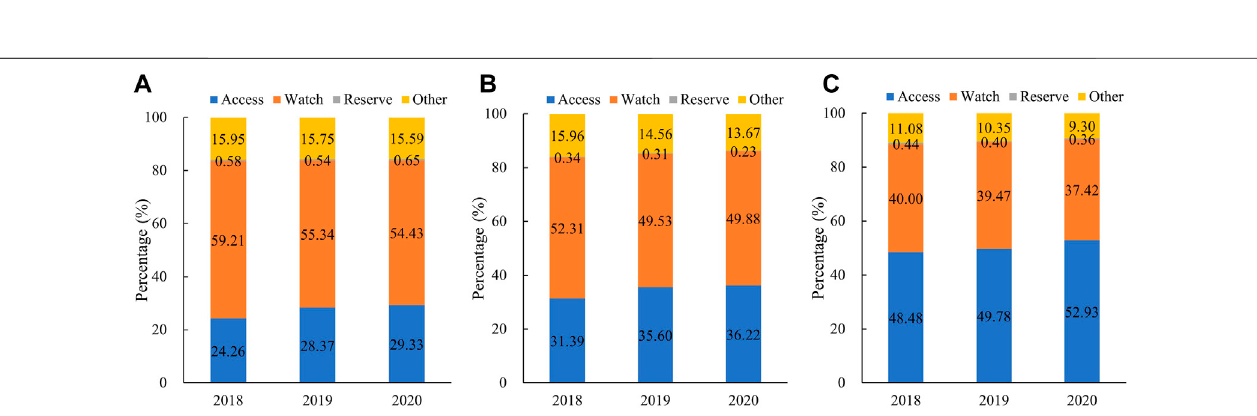
FIGURE 5 | Proportional consumption (%) of antibiotics by AWaRe categorization in different medical institutions in China, 2018 – 2020. (A) Tertiary hospitals, (B) secondary hospitals, and (C) PHCs. Note: Data of 24 provinces were involved. PHCs, primary healthcare centers.